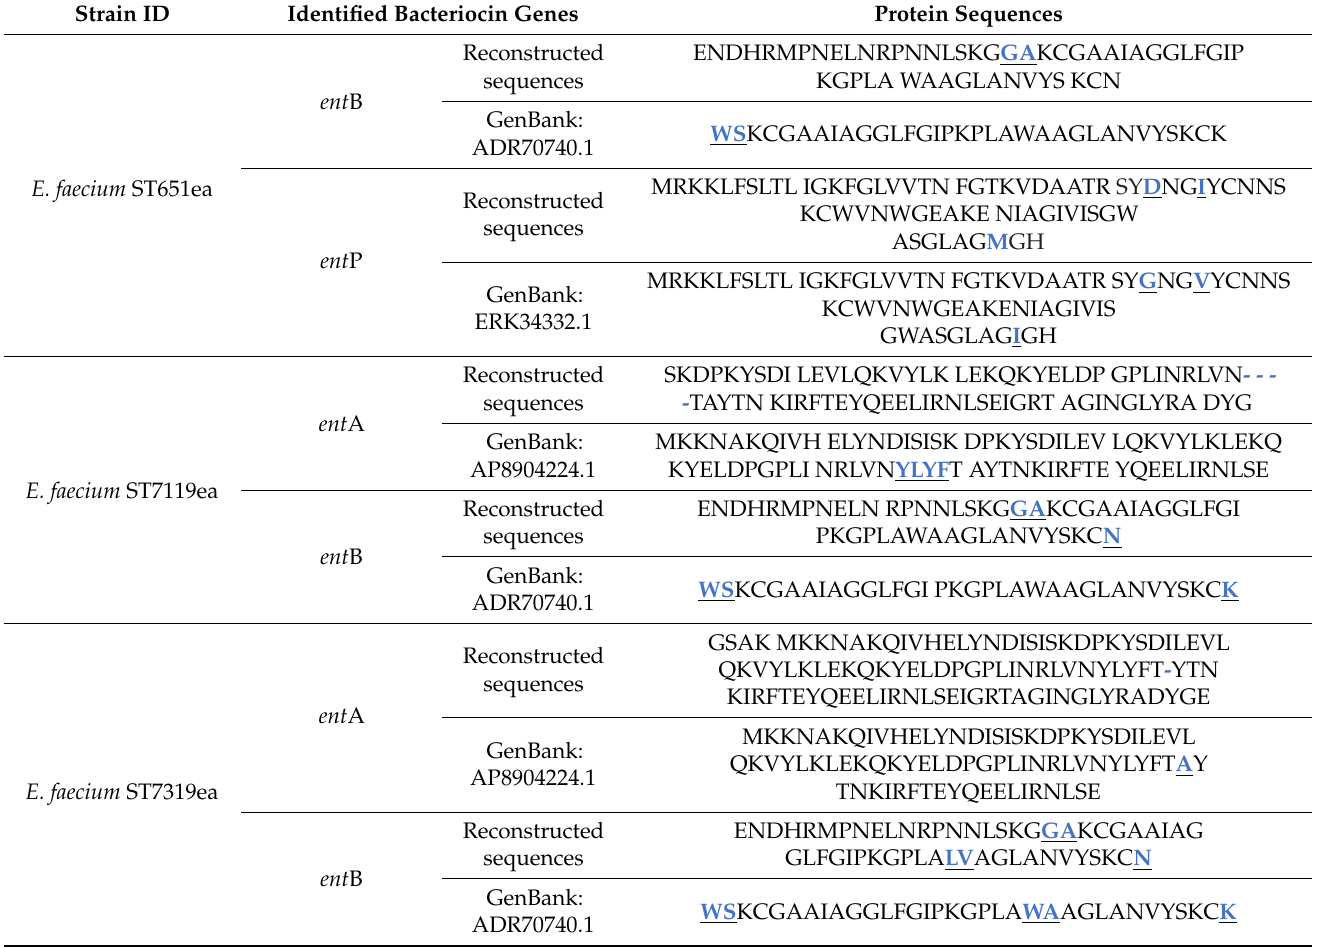
Table 2. Detected bacteriocin genes and predicted protein